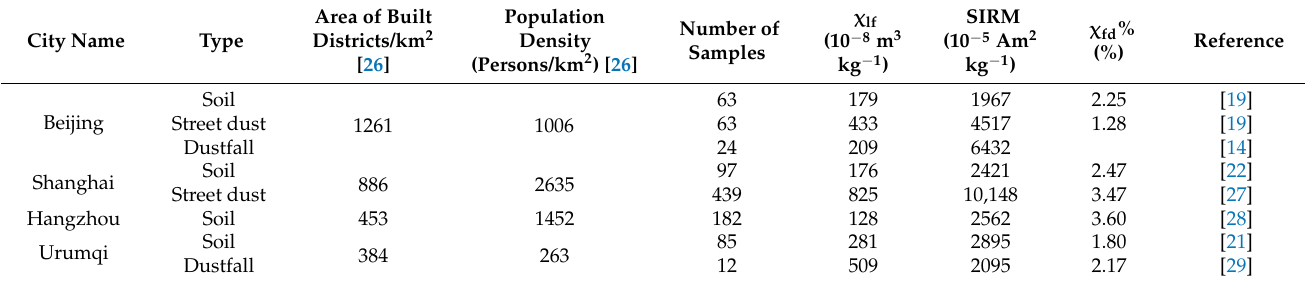
Table 2. Variations in population density and magnetic parameters of various environmental carriers in different cities in